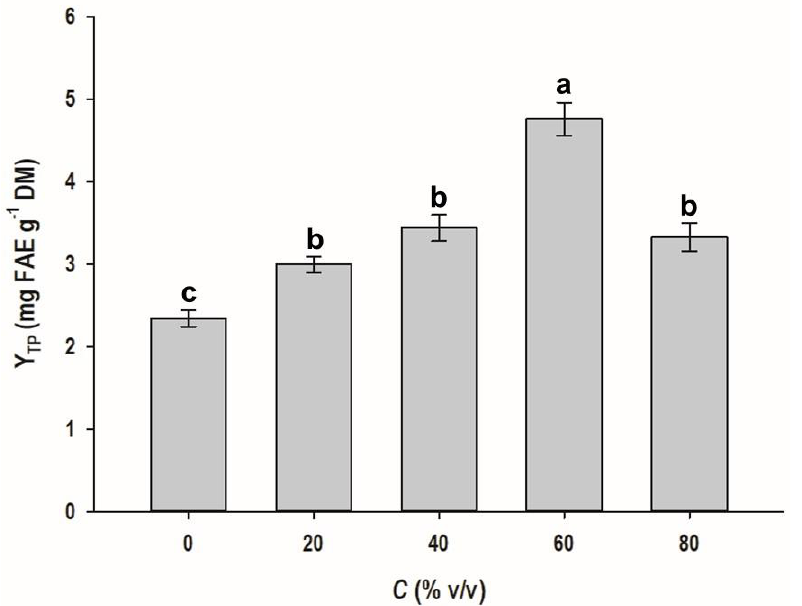
Figure 1. Effect of water/ethanol proportion on the extraction yield in polyphenols from wheat bran. Extractions were accomplished with the liquid-to-solid ratio of 10 mL g -1 , at 80 °C, for 180 min. Columns assigned with a, b, and c represent values with statistically significant difference ( p <